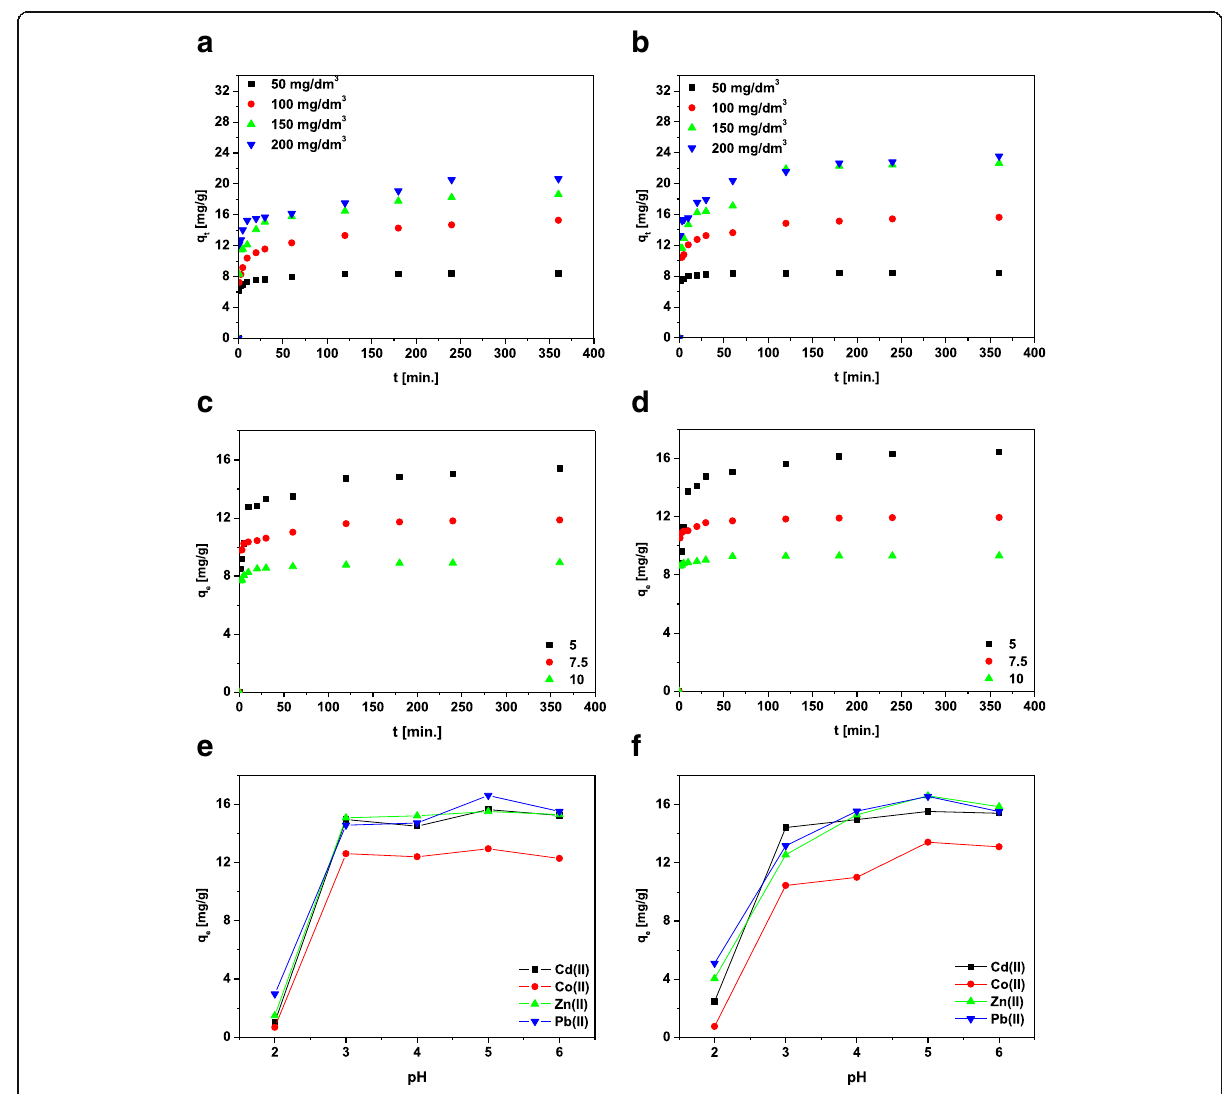
Fig. 1 Effect of the phase contact time on Cd(II) adsorption on a MBC1 and b MBC2, effect of dose of c MBC1 and d MBC2 on Cd(II) sorption and effect of pH on heavy metal ion sorption on e MBC1 and f